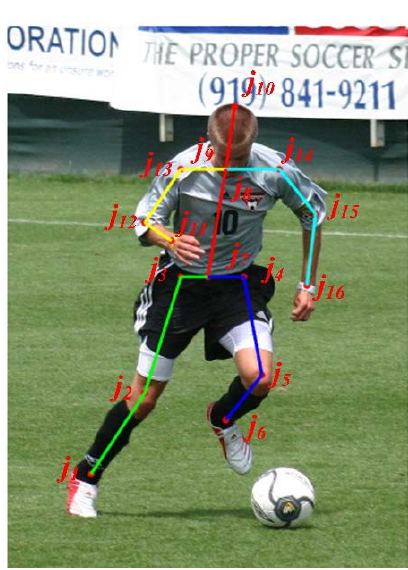
Fig. 4. An example of building a skeleton for an image from the Leeds Sports Pose Dataset test kit